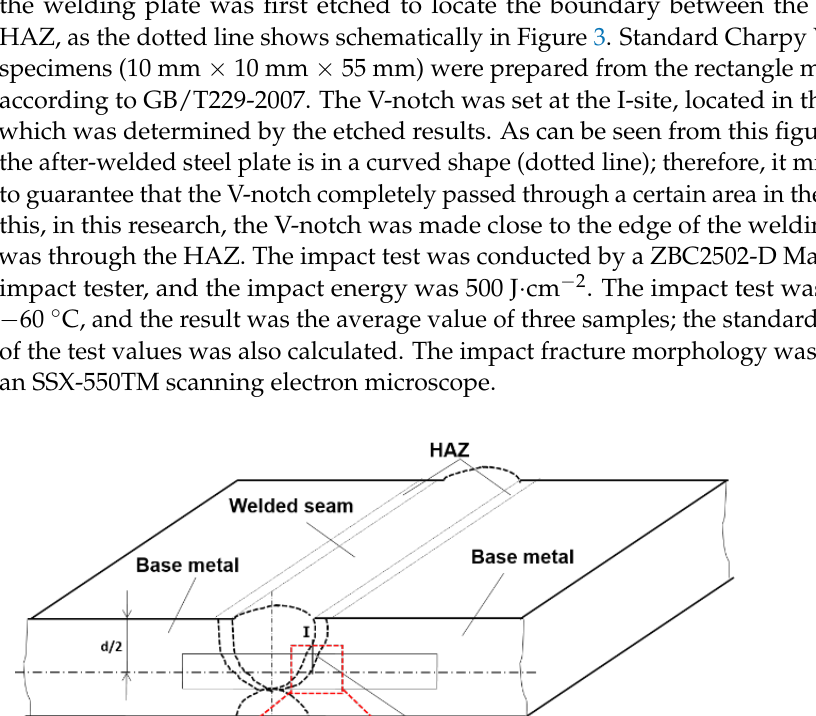
Figure 4. Position of micro-hardness measurement.